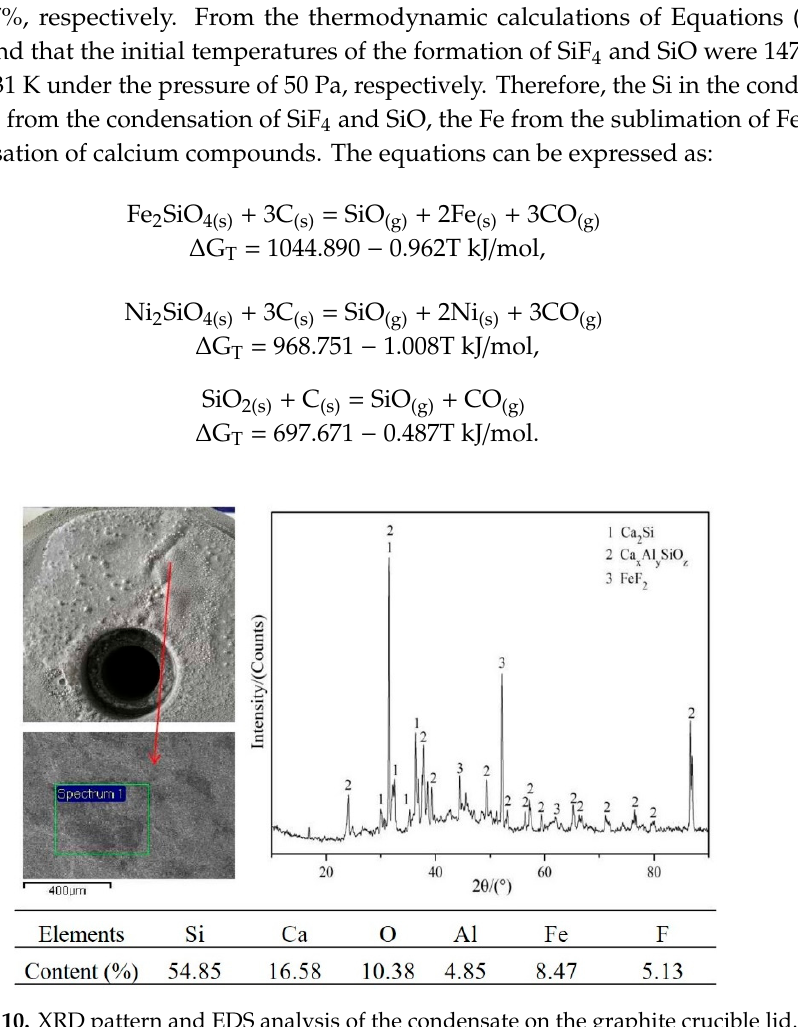
Figure 10. XRD pattern and EDS analysis of the condensate on the graphite crucible lid.